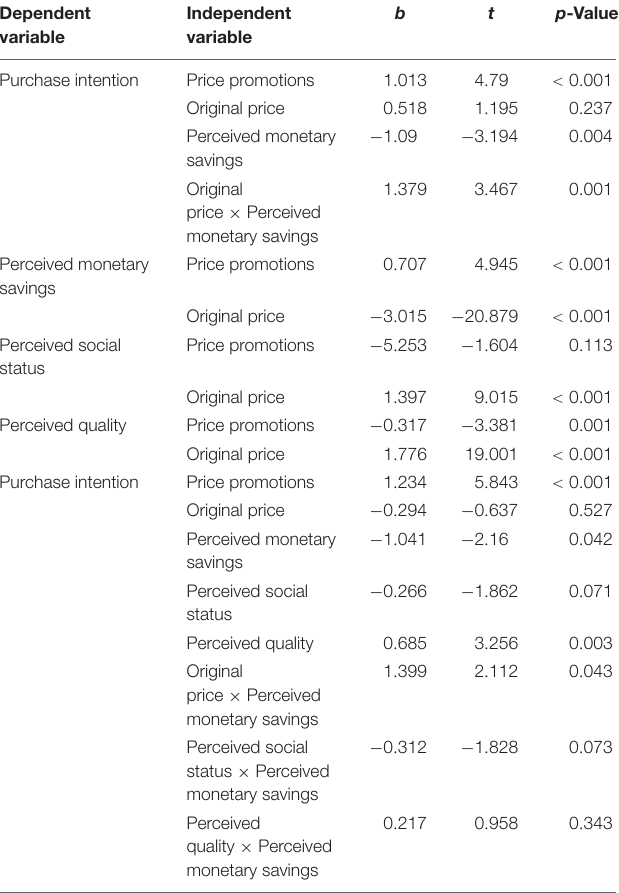
TABLE 2 | The linear mixed models (LMM) analysis results for mediation effect of perceived social status.